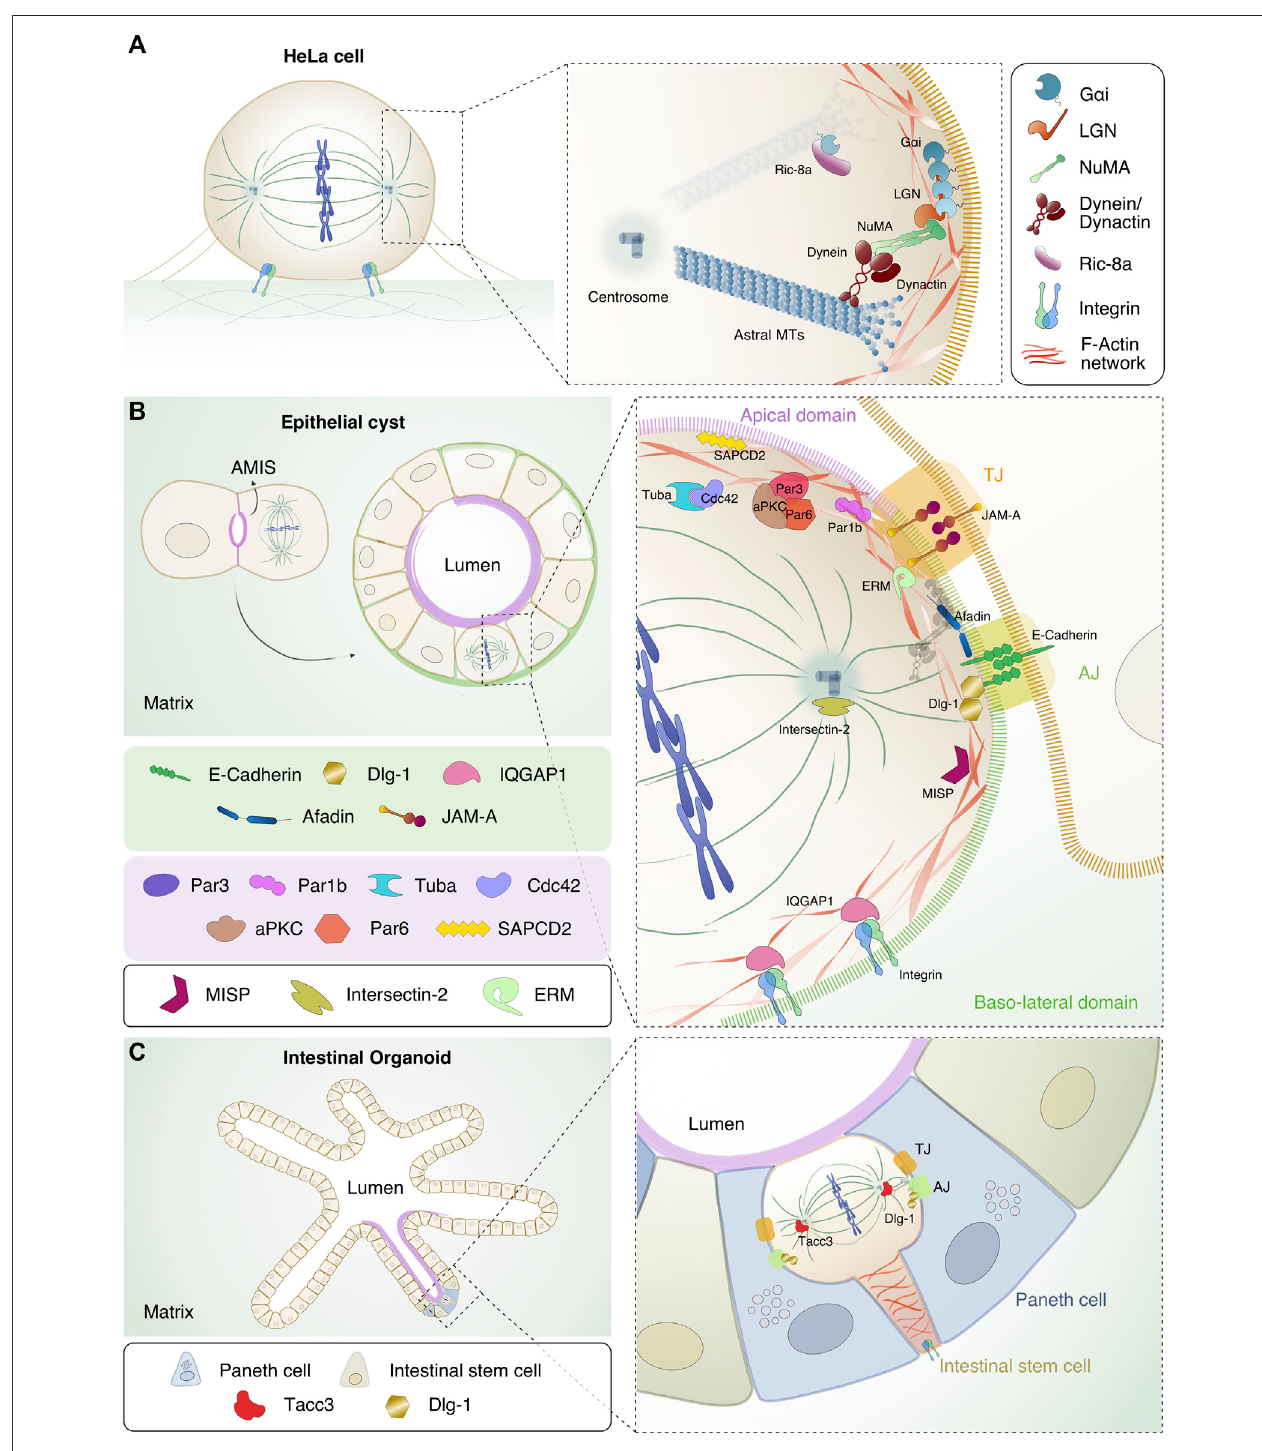
FIGURE 1 | Localizationand interaction ofthe spindle orientation and polarityproteins indifferent model systems. (A) HeLacellinmetaphase.Chromosomes(in blue) arealignedatthemetaphaseplateinthecentreofthecell,MTs(indarkgreen)formthemitoticspindleandintegrinsimportantforadhesionofthemitoticcelltothesubstratum, are shown inlight blue and green. Inthe inset,the details ofthe interaction interfacesbetween orientation proteinsG α i/LGN/NuMA, dynein/dynactin (in bordeaux) and astral MTs are shown. The G α i/NuMA/LGN complex is recruited at the lateral sides above spindle poles. NuMA is in green, LGN in orange and G α i in petrol blue. Ric8-A (in purple) is shown in the cytoplasm, close to the plasma membrane-bound G α i. (B) Evolution from two-cell stage, in which the mitotic spindle orients parallel to the AMIS, to mature cyst with a single lumen. The diving cell in the mature cyst has the mitotic spindle parallel to the apical side. In the scheme, the apical domain is highlighted in purple